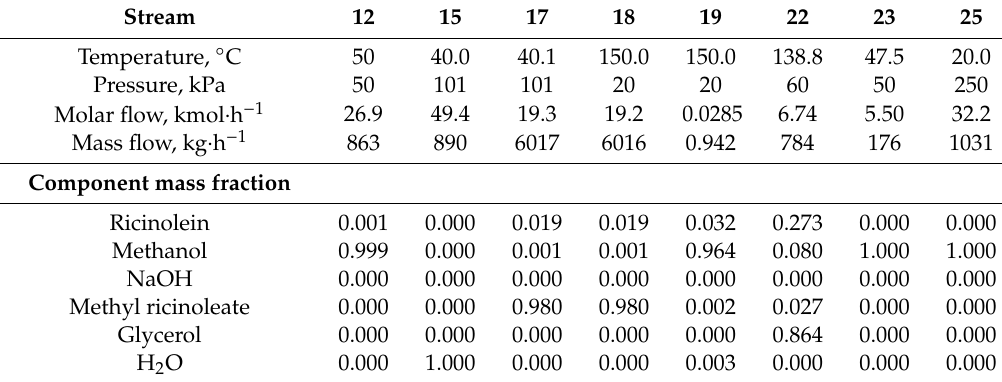
Table 6. Properties of the main streams (part II).